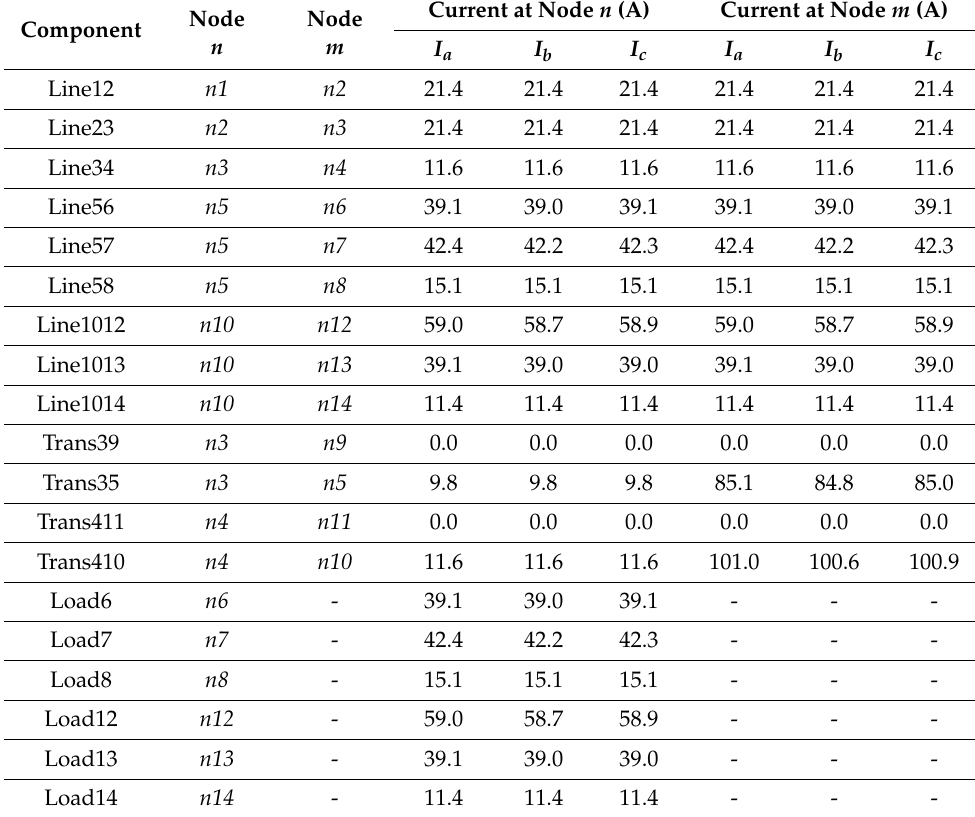
Table 2. Component line current magnitudes for the base